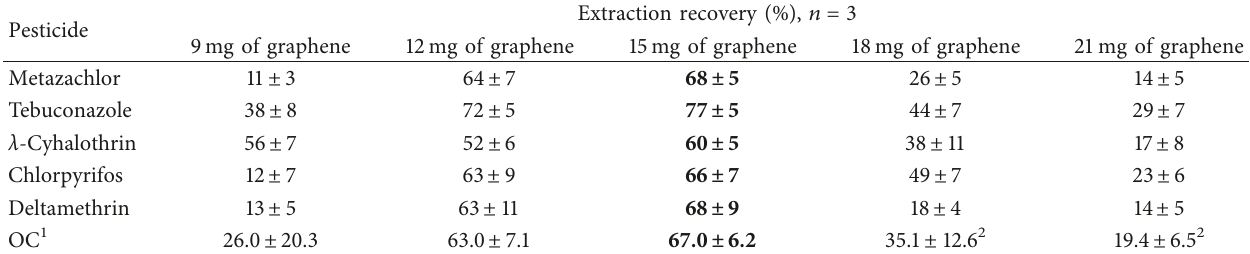
Table 1: Effect of the graphene amount on extraction efficacy of the five pesticides from rape oil samples. Pesticide